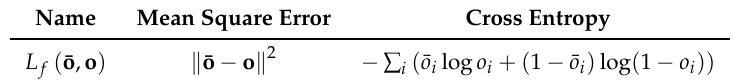
Table 2. Mathematical expressions for loss functions ( i denotes i -th element of a